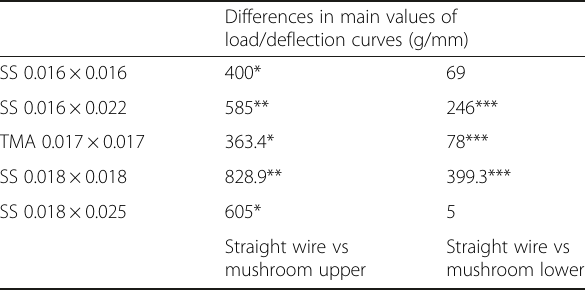
Straight wire vs mushroom upper